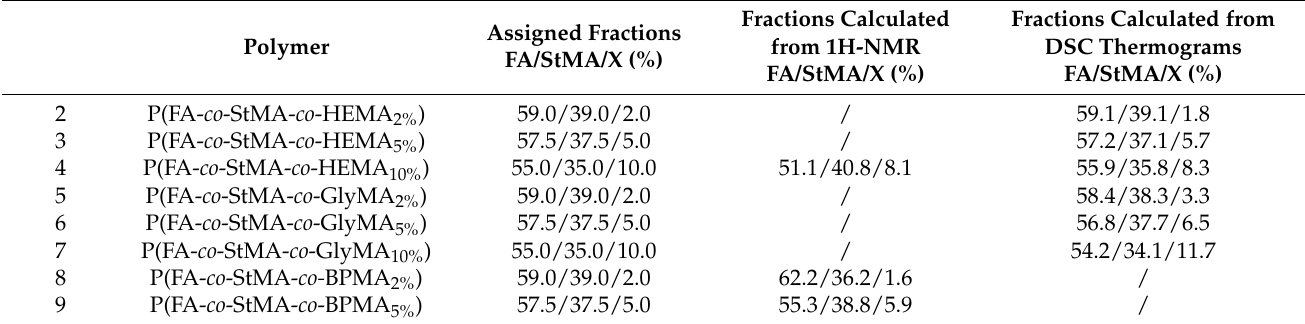
Table 2. List of the proportions of monomers used, as well as the polymerized proportions calculated by 1 H-NMR and DSC.